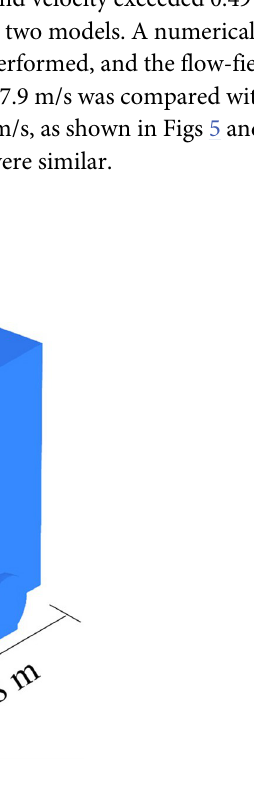
fields in the two models, i.e., the experimental model and the prototype physical tunnel, and EU values under different REs were calculated, as shown in Fig 4.